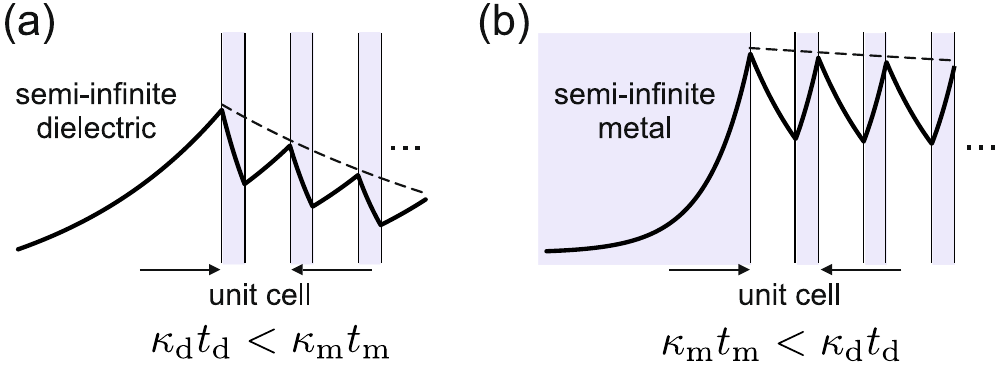
Figure 2. Magnetic field variation on homointerfaces for ( a ) dielectric and ( b ) metallic capping medium. The requirement that the Bloch anvelope, indicated by dashed lines, decays towards infinity on the right, yield the condition that κ d t d < κ m t m and κ d t d > κ m t m for ( a , b ), respectively. Note that the values of κ d and κ m used in panels ( a , b )